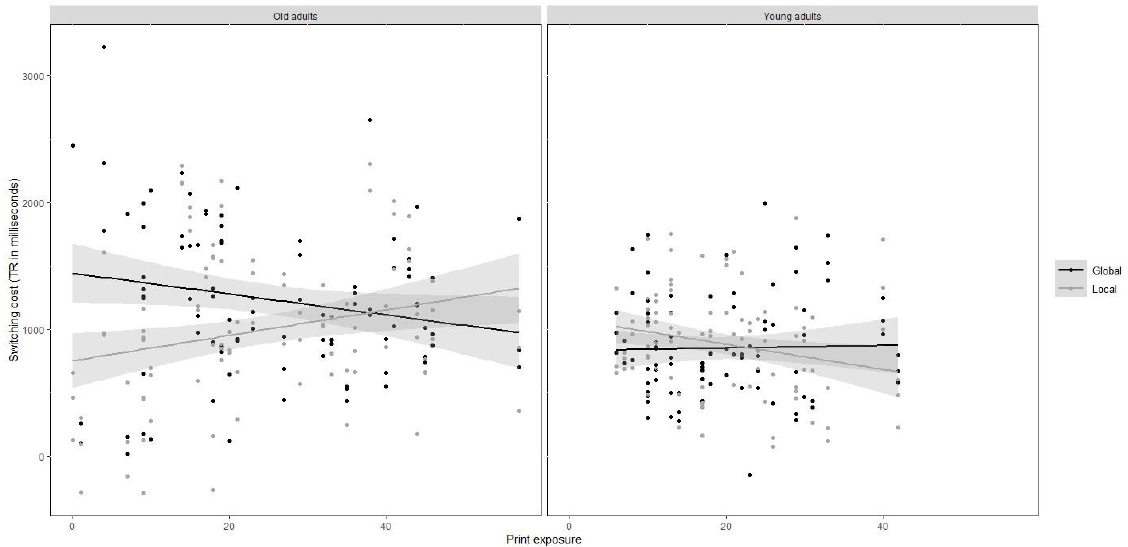
Figure 4. Mixing cost in reaction times (in milliseconds, i.e., switching trials minus non-switching trials) obtained in the global-local task as a function of group, condition and print exposure (literacy experience).